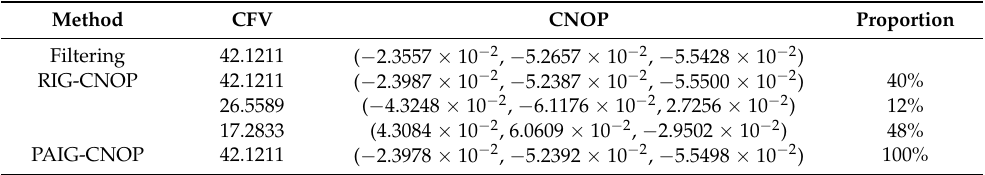
Figure 7. The distribution of the MCFVs corresponding to the CNOPS generated by the different methods at point B , T = 500. Table 6. Statistical analysis of the MCFVs corresponding to the CNOPS generated by the different methods at point B , T = 500 .